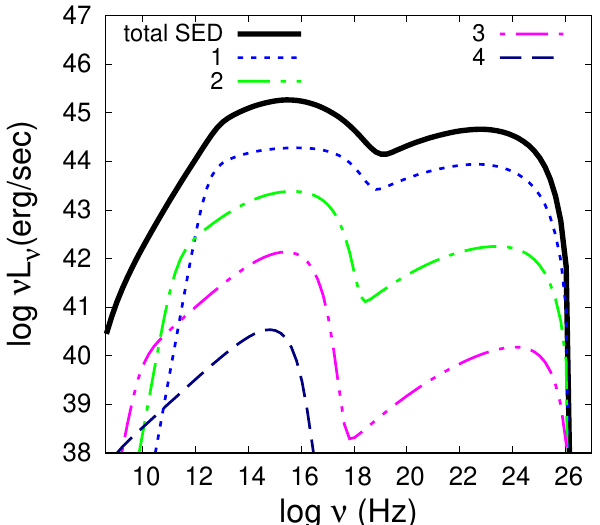
Figure 1. Steady-state SED of a fiducial BL Lac source (thick black line), computed by superimposing the emission of 10 4 blobs that are produced continuously at distance z 0 = 10 − 3 pc from the central engine. For illustration purposes, we show the spectra of a few indicative blobs (1 : R 1 = 10 15.5 cm, z 1 = 1.6 × 10 − 3 pc; 2 : R 2 = 10 16.5 cm z 2 = 7 × 10 − 3 pc; 3 : R 3 = 10 17.5 cm, z 3 = 6 × 10 − 2 pc; 4 : R 4 = 10 18.5 cm, z 4 = z final = 6 × 10 − 1 pc). All blobs are initialized with the same parameters: = 10 42 erg s − 1 , u exp = 0.3 c, γ = 1, γ max = 10 5 , p = 2, Γ = 5 and B 0 = 10 G, R 0 = 10 15 cm, L inj e min 0 δ = 10. The magnetic field and electron injection luminosity decrease linearly with